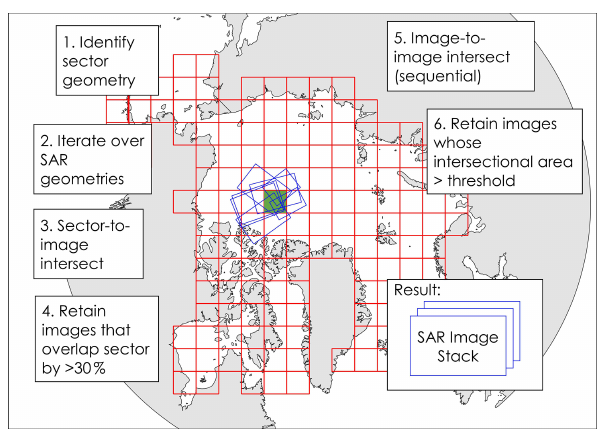
Figure 6. Processing steps for automatically generating the S1 or RCM synthetic aperture radar (SAR) image stack selection.